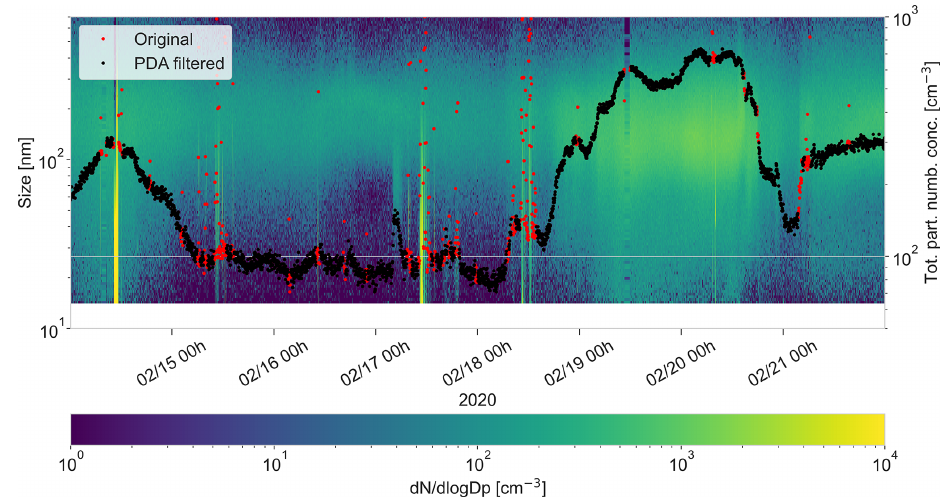
Figure 6. Application of the PDA to the total number concentration dataset (black line) collected by an SMPS. Data points identified as polluted by the PDA are marked in red. The dataset is plotted over the particle size distribution data of the same instrument.